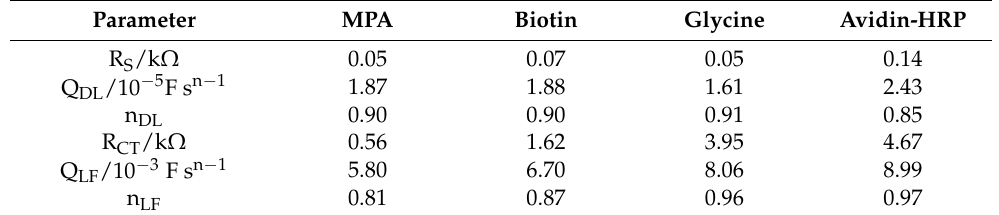
Table A1. Parameters’ values obtained by EIS to PPy e PPy/AuNPs, in electrode modification steps. Parameter MPA Biotin Glycine